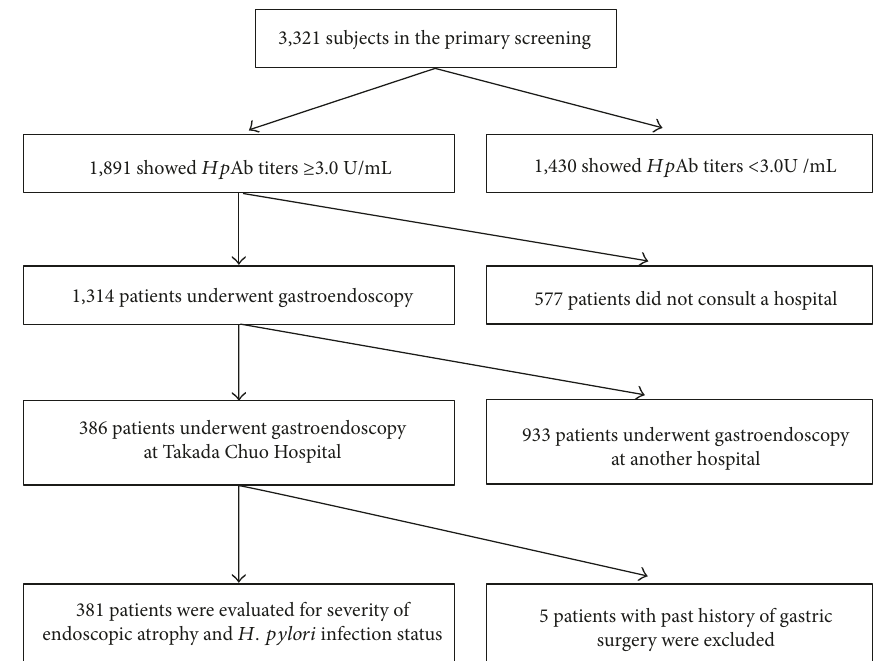
Figure 1: Patient fl ow. Among the 3321 primary screening subjects, 56.9% (1891/3321) showed Hp Ab ≥ 3.0U/mL and 69.5% of these patients (1314/1891) could participate in secondary screening and underwent gastroendoscopy. On the other hand, 30.5% (577/1891) patients did not consult a hospital. Among 1314 patients who underwent gastroendoscopy, 386 patients consulted at Takada Chuo Hospital and underwent gastroendoscopy and 381 patients were able to evaluate severity of endoscopic atrophy and Hp infection status. On the other hand, 5 patients with past history of gastric surgery were excluded. In addition, 39 patients with past history of eradication therapy for H. pylori infection were included.